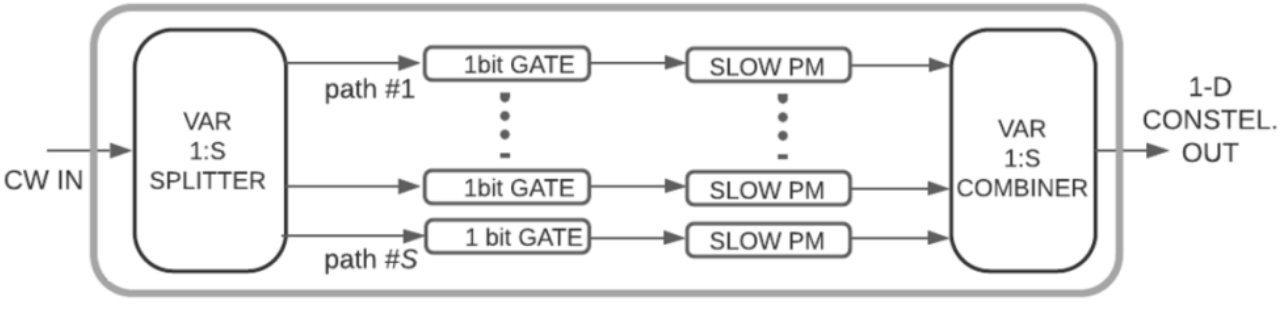
Figure 20. Parallel architecture proposed in